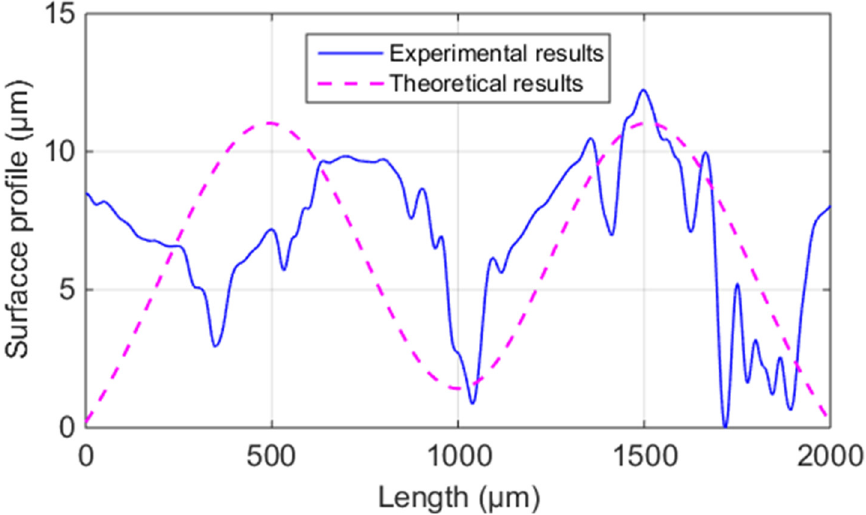
Figure 13. Theoretical and average experimental results of the surface profile of the ME samples parallel to the fiber direction.